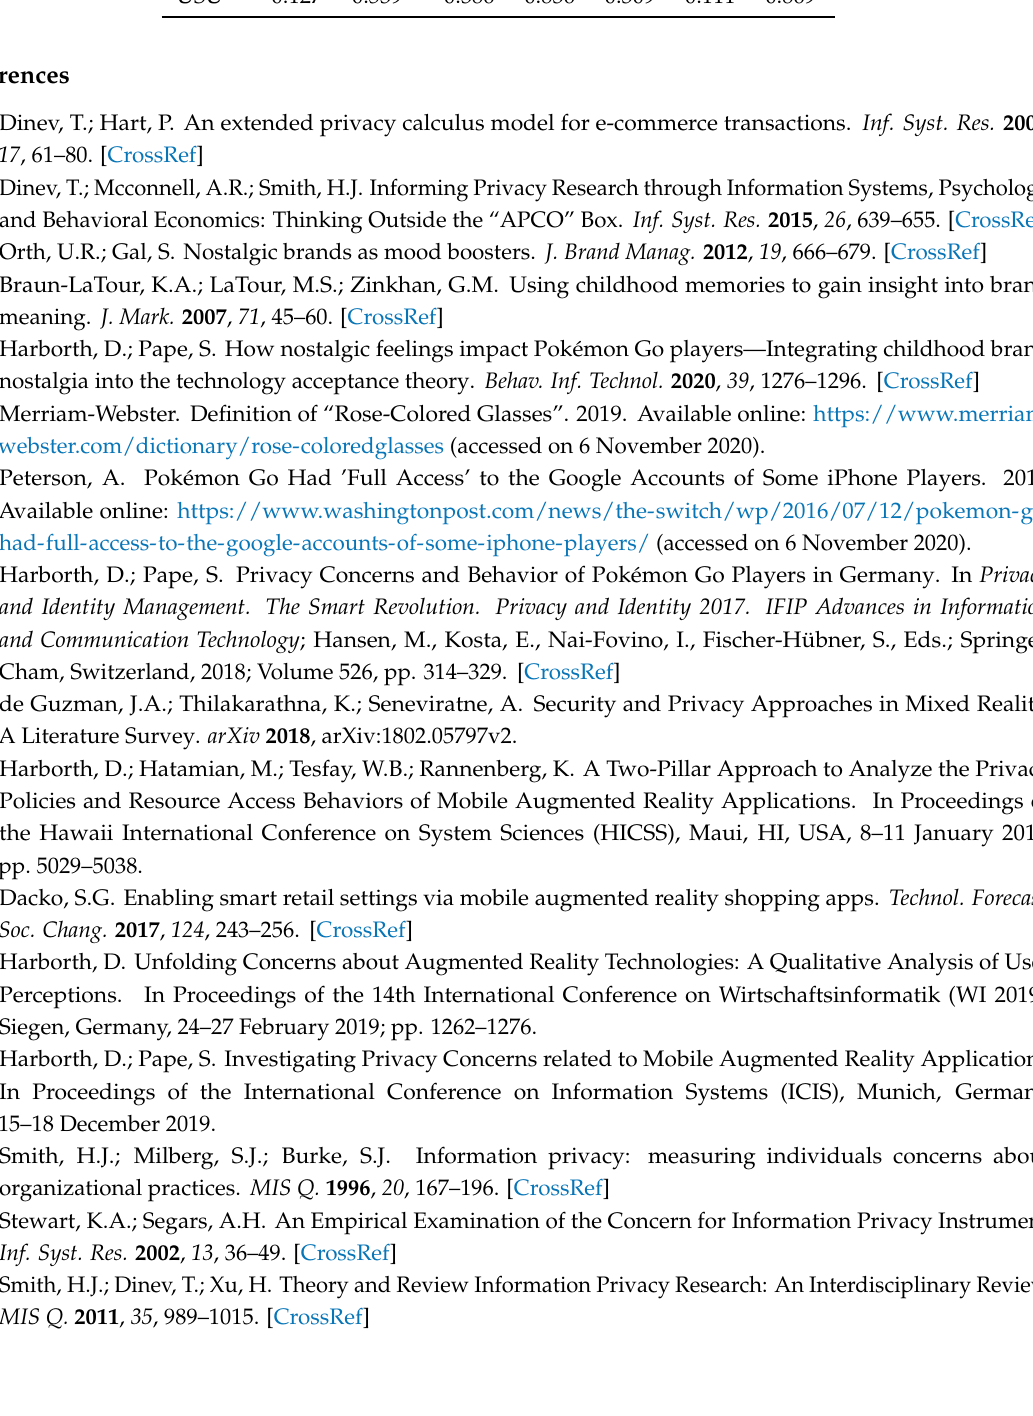
√ AVE -values are on the